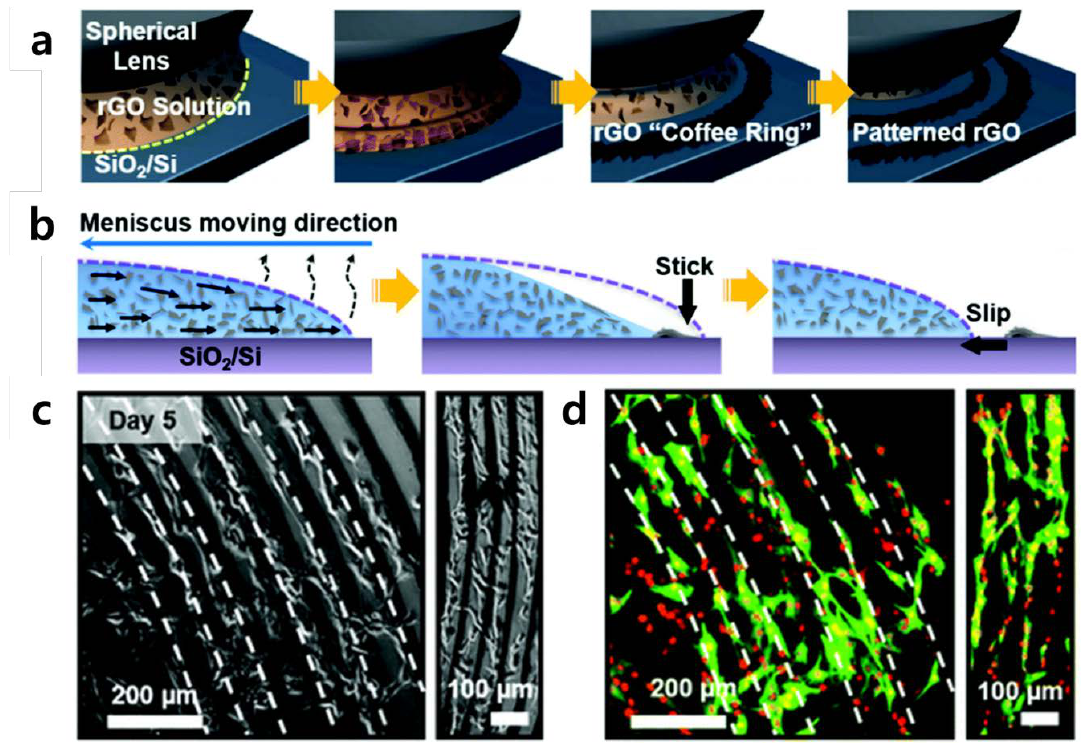
Figure 5. ( a ) Schematic illustration of rGO coffee-ring array manufacturing process. ( b ) Cross-sectional view of the formation of an rGO coffee-ring array. ( c , d ) Cell guidance effect of rGO coffee-ring array on C2C12 cells. ( c ) Optical microscopic and ( d ) fluorescence images of C2C12 cells cultured for 5 days. Alpha-smooth muscle actin (SMA) was stained with a FITC-conjugated anti-SMA antibody (green), and the cell nucleus was counterstained with PI (red). The reprint of this figure from [91] is permitted by the Royal Society of Chemistry.